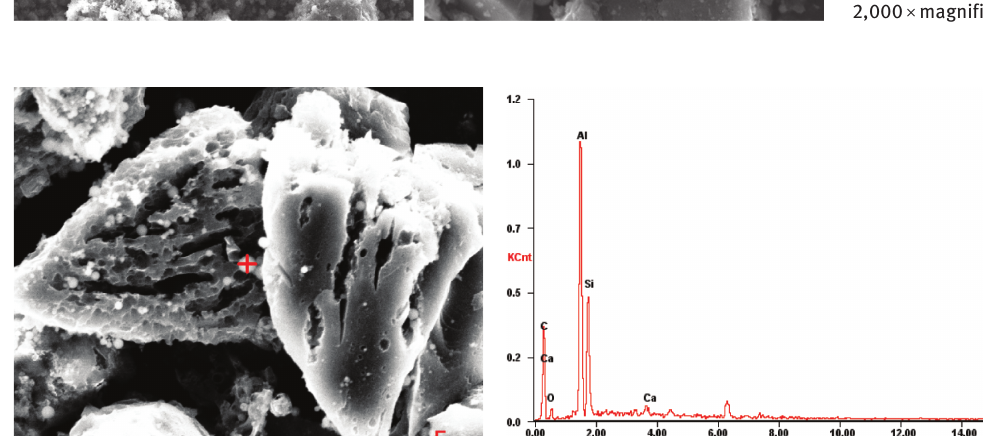
Figure 6: Microstructure under 2,000 × magnification.